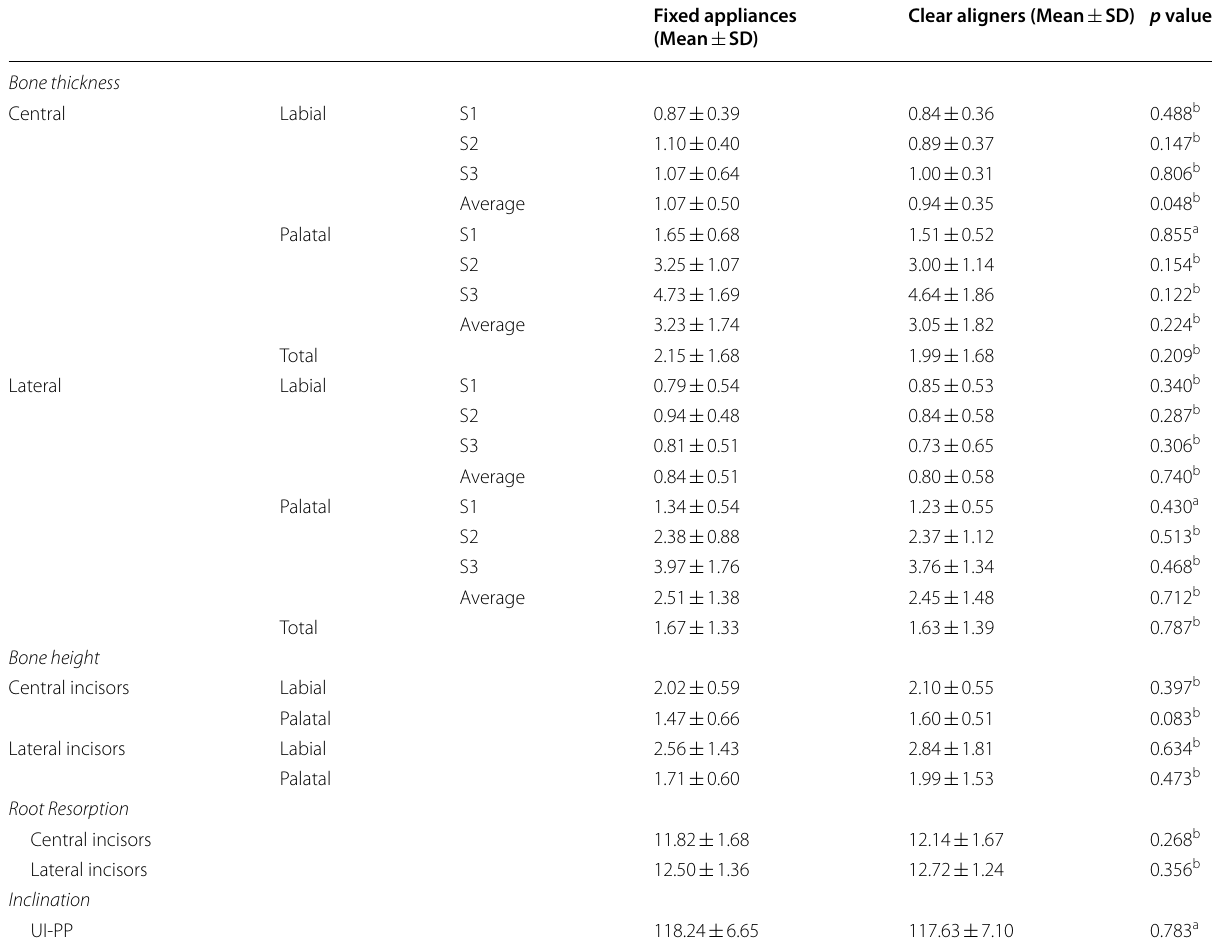
a: Independent sample t test, b: Mann–Whitney U